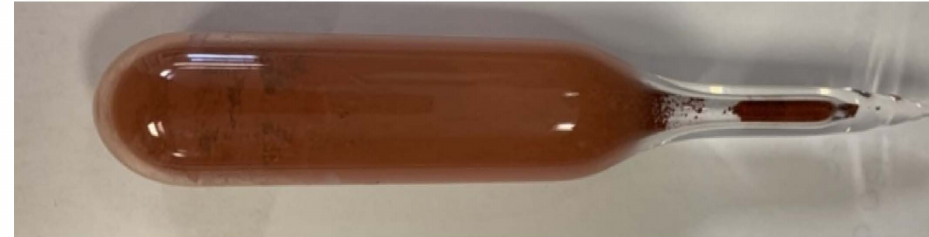
Figure 1. Quartz glassware used for the